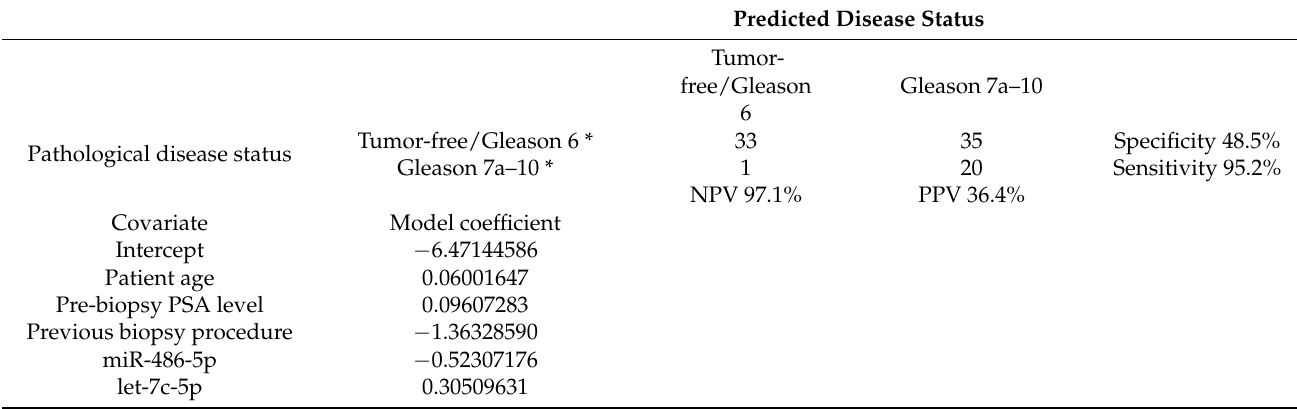
Table 3. Comparison of pathological and predicted outcome; covariates and regression coefficients of the regression model for predicting significant PCa in patients with PI-RADS scores 1, 2, and 3. For binomial classification, the optimized threshold of 14% risk was